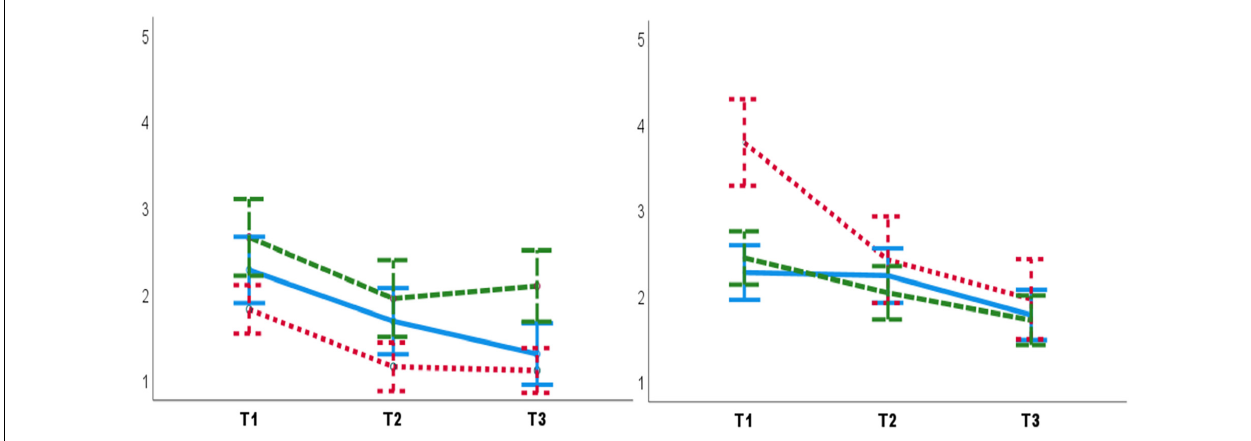
FIGURE 5 | Lower subjective stress was reported to female experimenters (left panel) in the PG T3 (post-test) compared to the female experimenters in the PCG T3. Higher subjective stress was reported to male experimenters (right panel) in the PG T1 (pre-test), compared to male experimenters in T1. T1: pre-test. T2: manipulation trial/control. T3: post-test. Blue lines: CCG. Green dashed lines: PCG. Red dashed lines: PG. Error bars: ± 1 SE